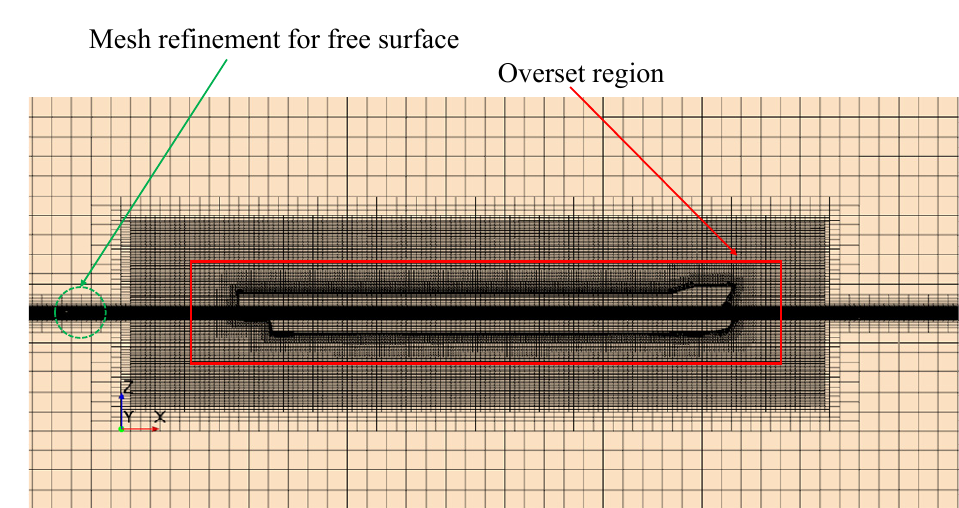
Figure 3. Meshing of section perpendicular to the Y-axis.